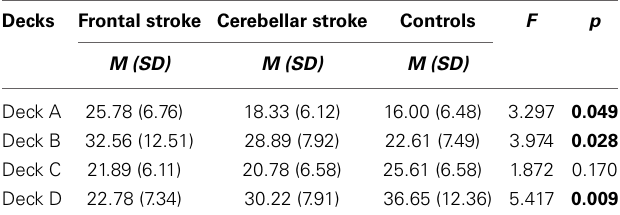
Table 3 | Analysis of deck preferences. Decks Frontal stroke Cerebellar stroke